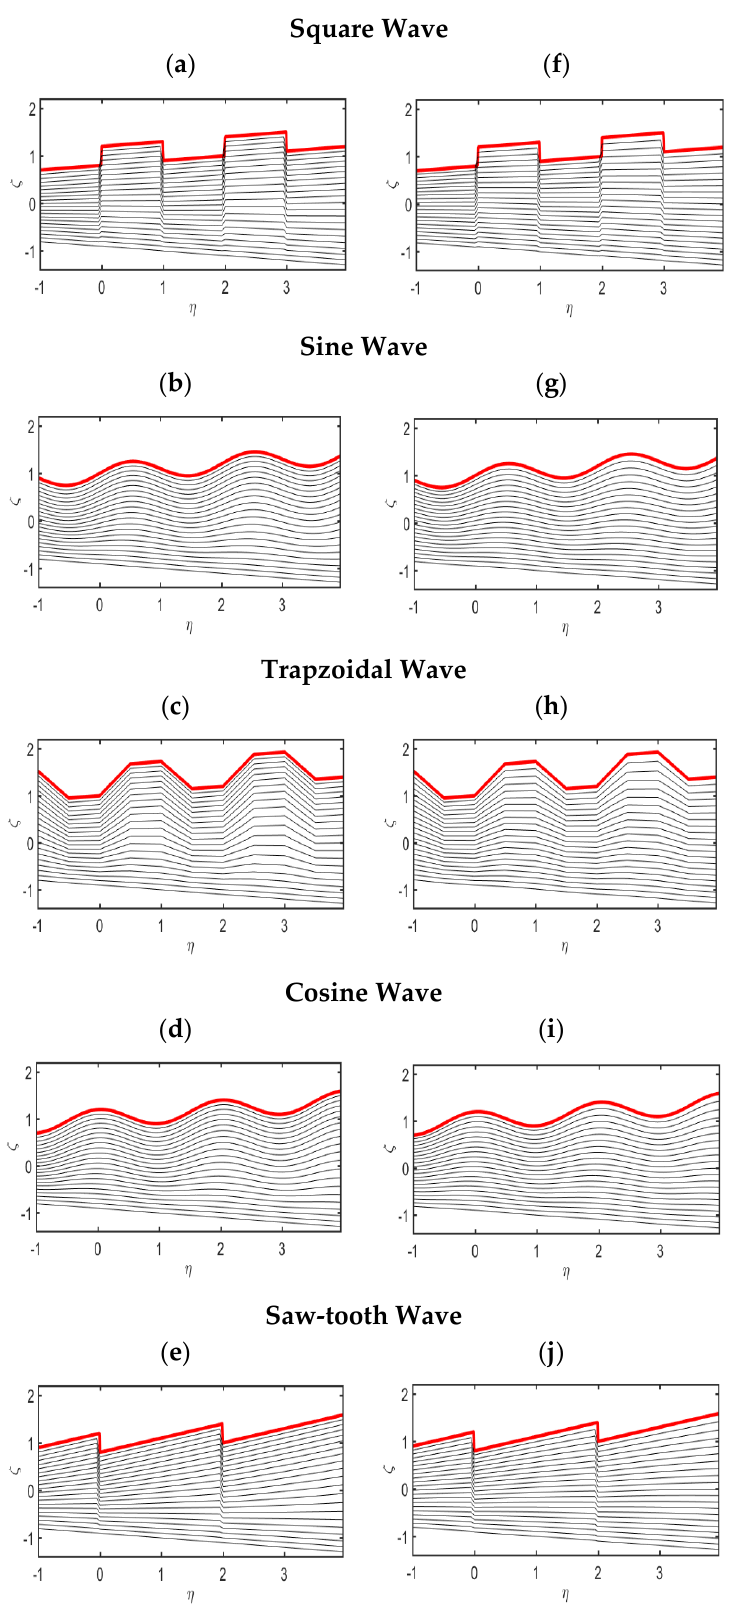
Figure 8. Trapping phenomena for non-uniform parameter (𝛼 = 0,0.1) using ( a , f ) square wave, ( b , g ) sine wave, ( c , h ) trapezoidal wave, ( d , i ) cosine wave, ( e , j ) saw-tooth wave at 𝑞 = −2,𝐷𝐴 = 10,𝛼 = 0.1,𝜎 = 3,and 𝜙 = 0.2.